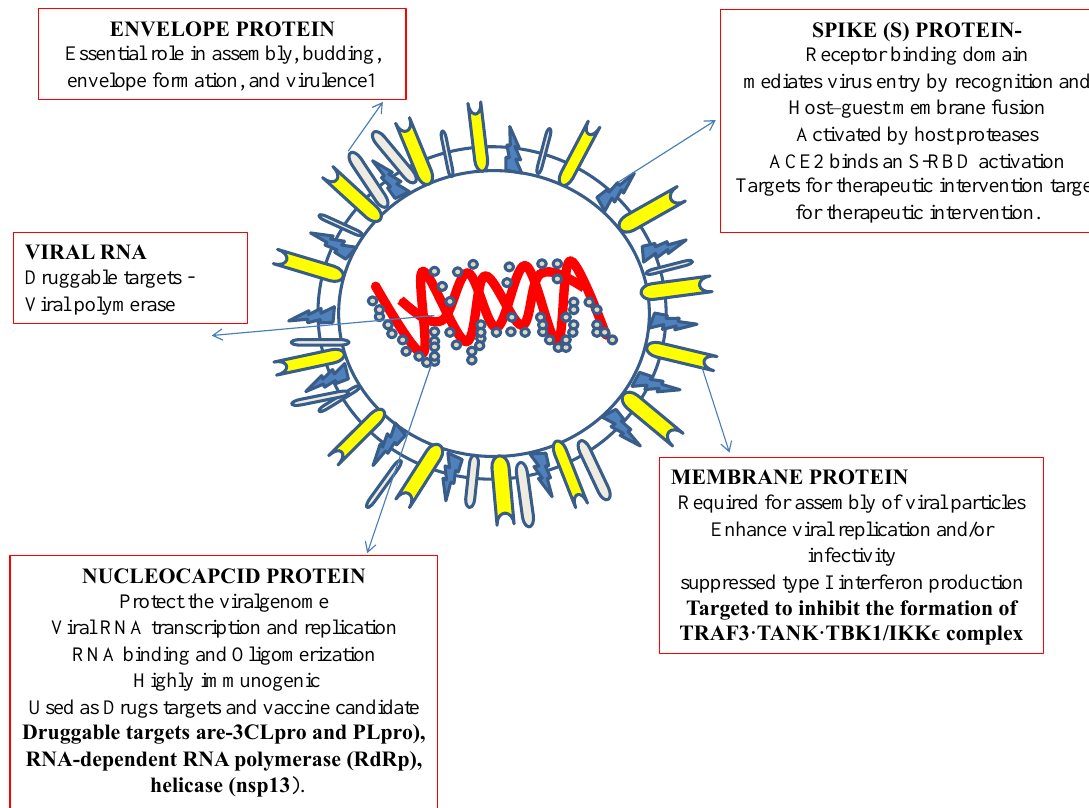
Figure 1. Structural features of a coronavirus.